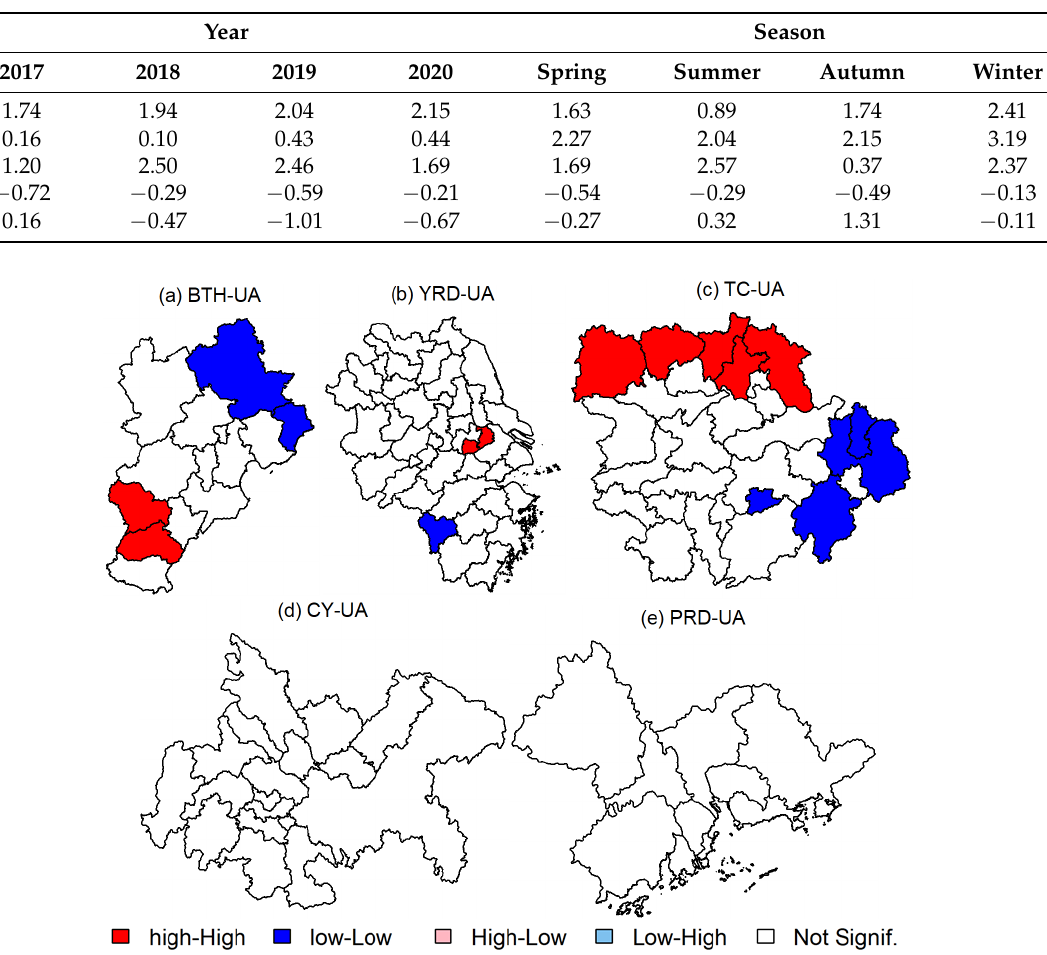
Table 1. Annual and seasonal variations of global Moran’s I index of O 3 concentrations in five urban agglomerations.